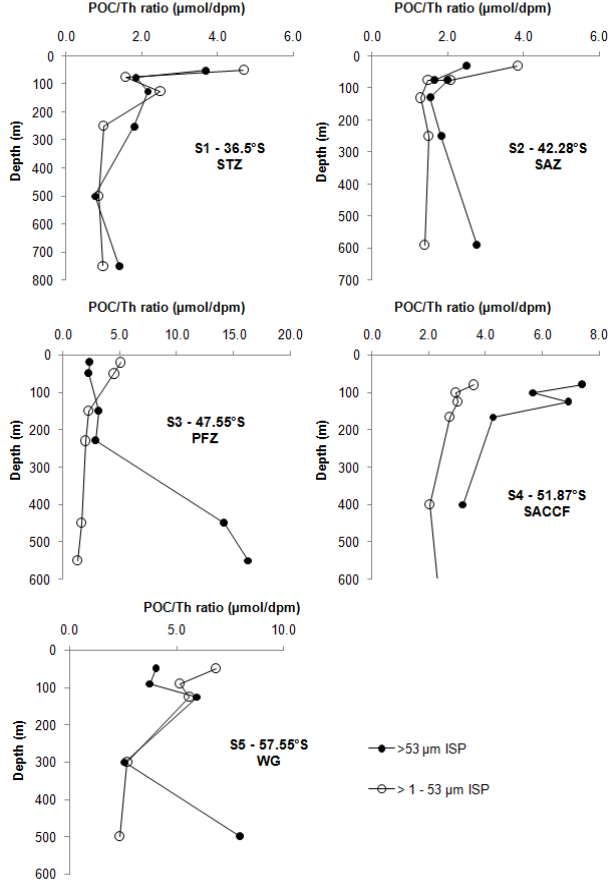
Fig. 5. Vertical profiles of POC/ 234 Th p ratio (µmoldpm − 1 ) for the 1–53µm and > 53µm size fractions at Super stations S1 to S5. ISP refers to In Situ Pump sampling.